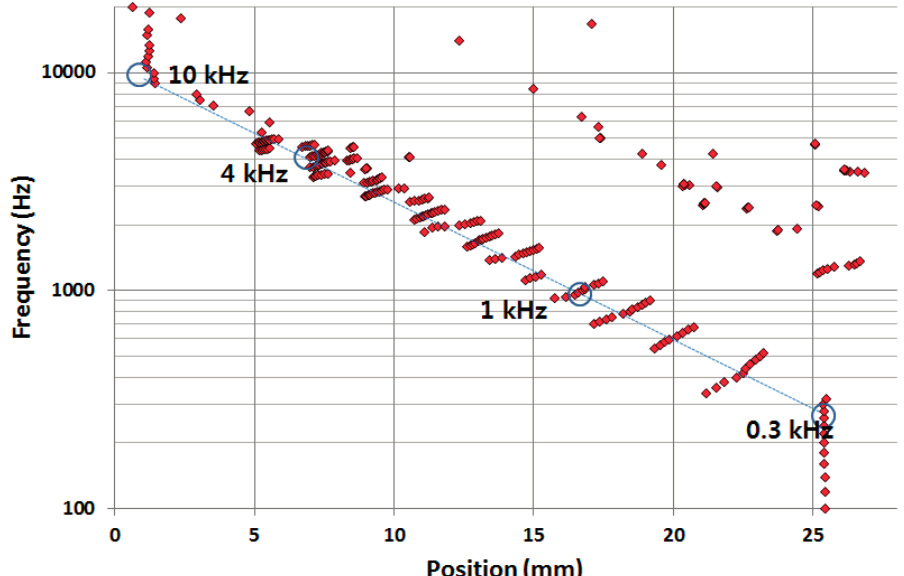
Figure 5. Frequency separation FEA of the designed PAC with a liquid chamber: each red dot corresponds to the position having maximum displacement at each